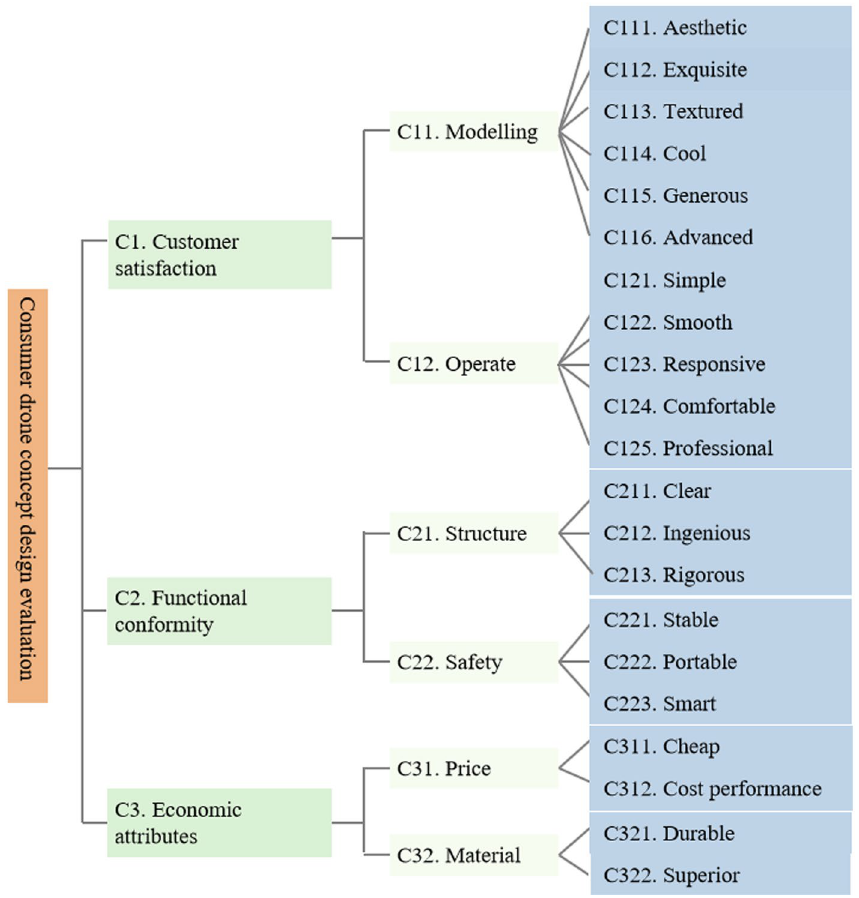
Figure 3. Consumer drone concept design evaluation criteria system.